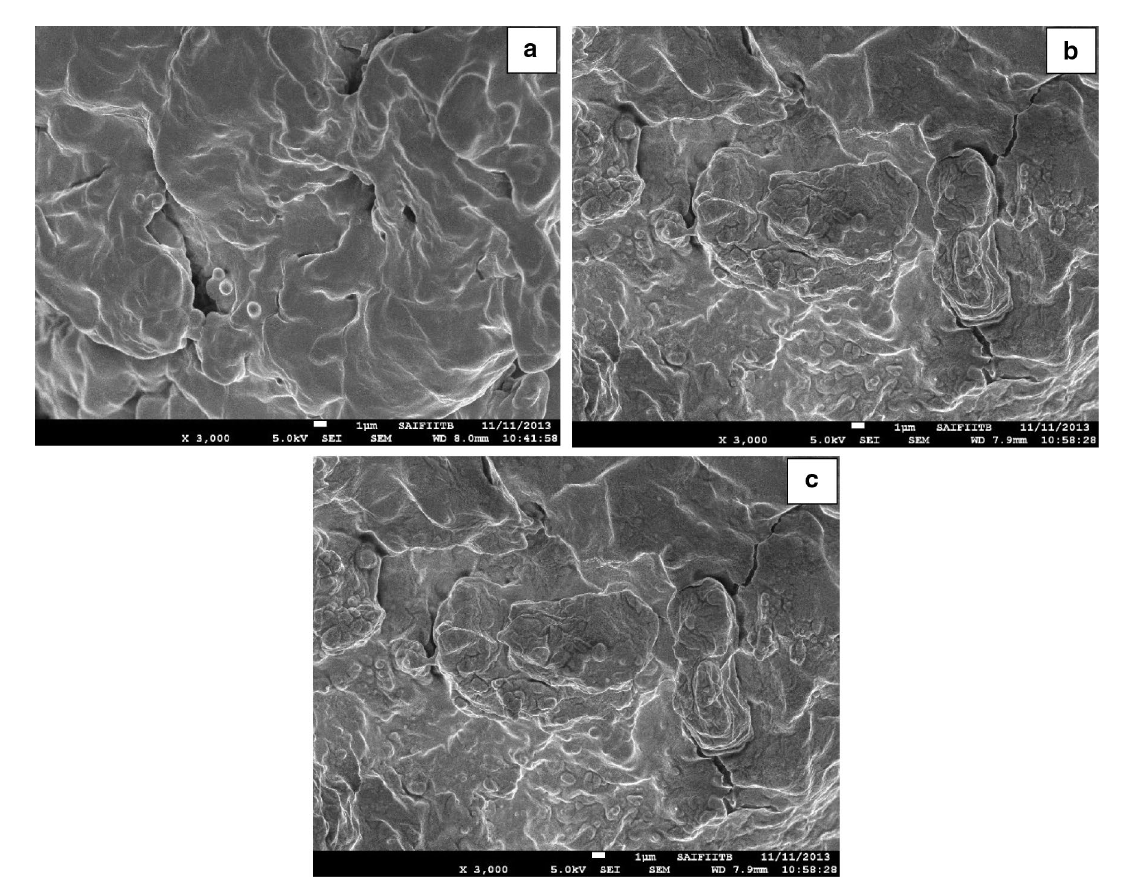
Fig. 3 SEM micrographs of a un-activated, b activated and c activated metals-loaded adsorbent at 3000×